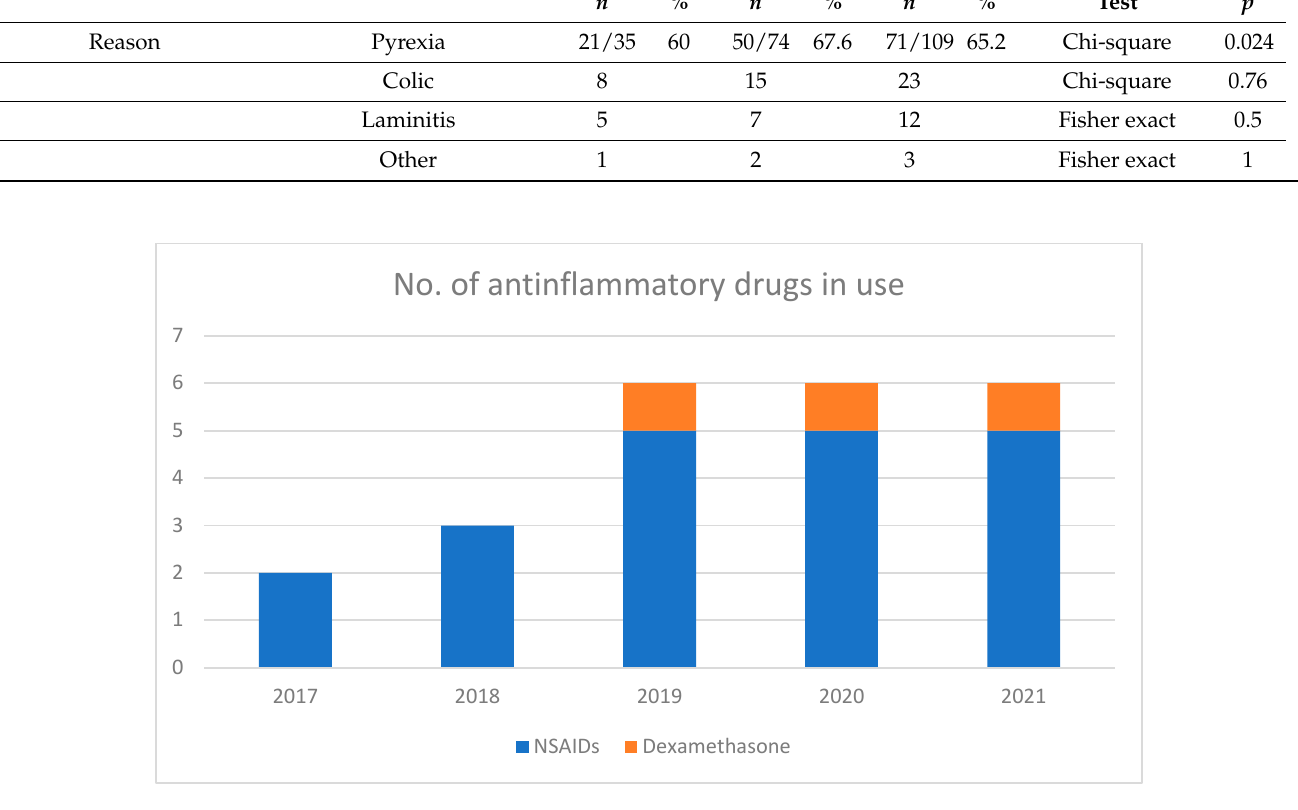
Figure 2. Number of anti-inflammatory drugs or dosages administered postoperatively from post- operative day three over the standard, initial postoperative regimens (flunixin meglumine 0.5 mg/kg IV BID, flunixin meglumine 1.1 mg/kg IV BID, ketoprofen 2.2 mg/kg SID, phenylbutazone 2.2 mg/kg SID, dexamethasone 1.1 g/kg single dose intra-operative).